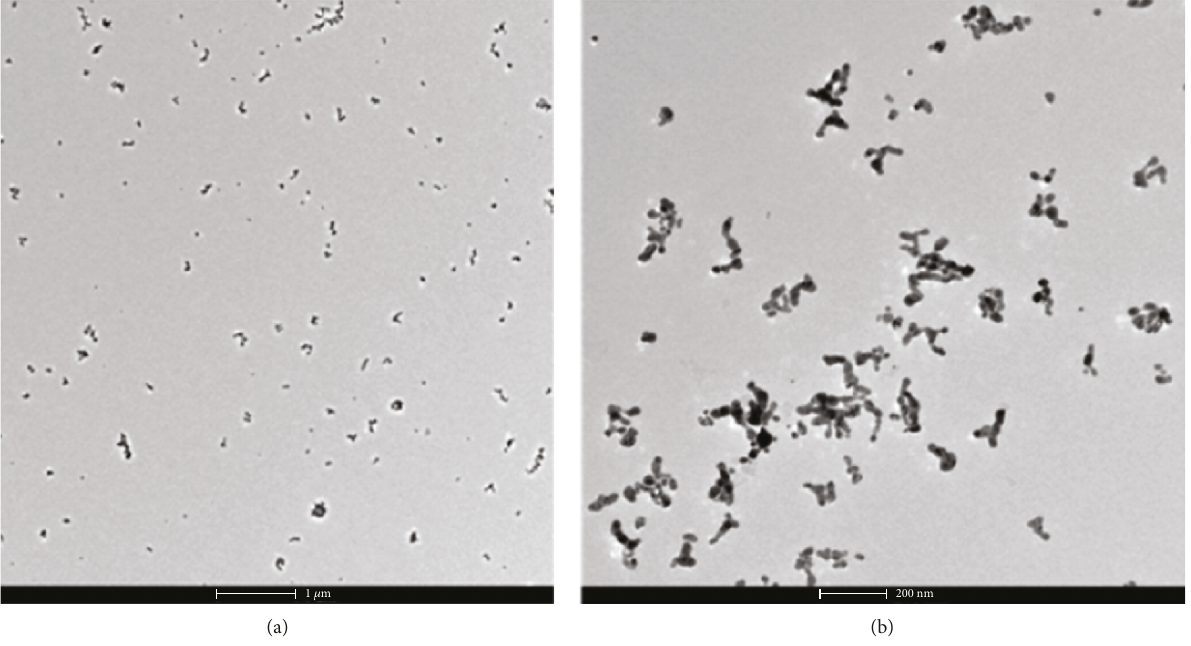
Figure 1: TEM image of Ag sol, synthesized in D-g-PNIP АМ